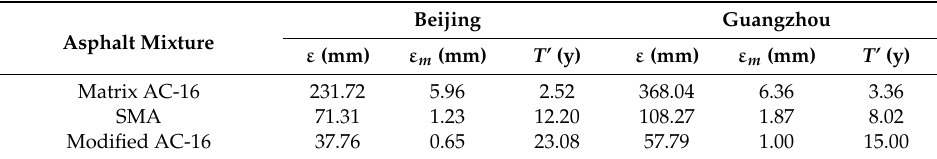
Table 8. Modified annual rut depths and service lives of three asphalt